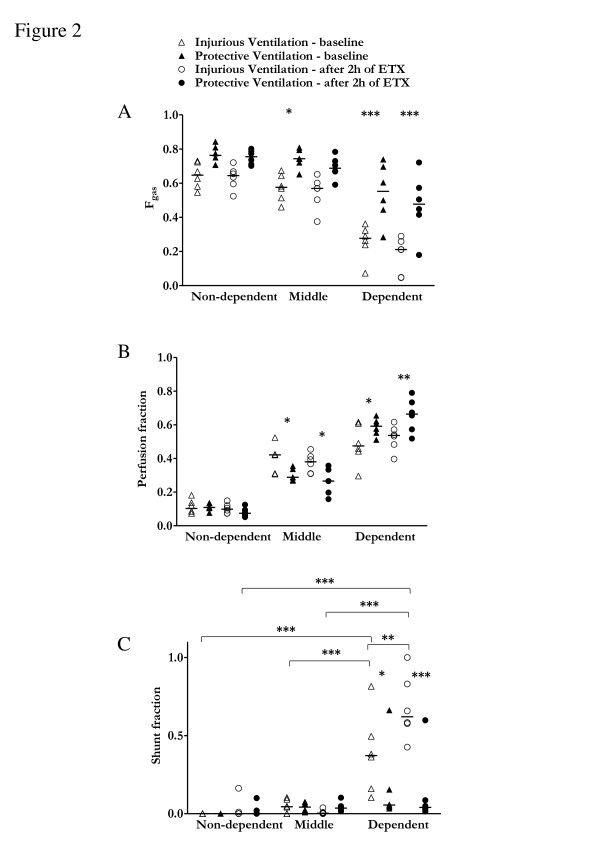
Regional gas, perfusion and shunt fractions. Gas fraction (fgas) (A), perfusion fraction (B) and shunt fraction (C) for isogravitational (dependent, middle and nondependent) regions of interest of injurious (open symbols) and protective ventilation (filled symbols) groups at baseline (triangles) and after (circles) 2 h of mechanical ventilation and endotoxemia (ETX). fgas and perfusion fraction were stable over time in both groups. In contrast, shunt fraction dramatically increased over time in dependent regions of the injurious ventilation group, but not in those of the protective ventilation group. Horizontal lines represent median values. *P < 0.05, **P < 0.01 and ***P < 0.001. P values are derived from two-way analysis of variance with repeated measurements and Bonferroni adjustments for multiple comparisons.